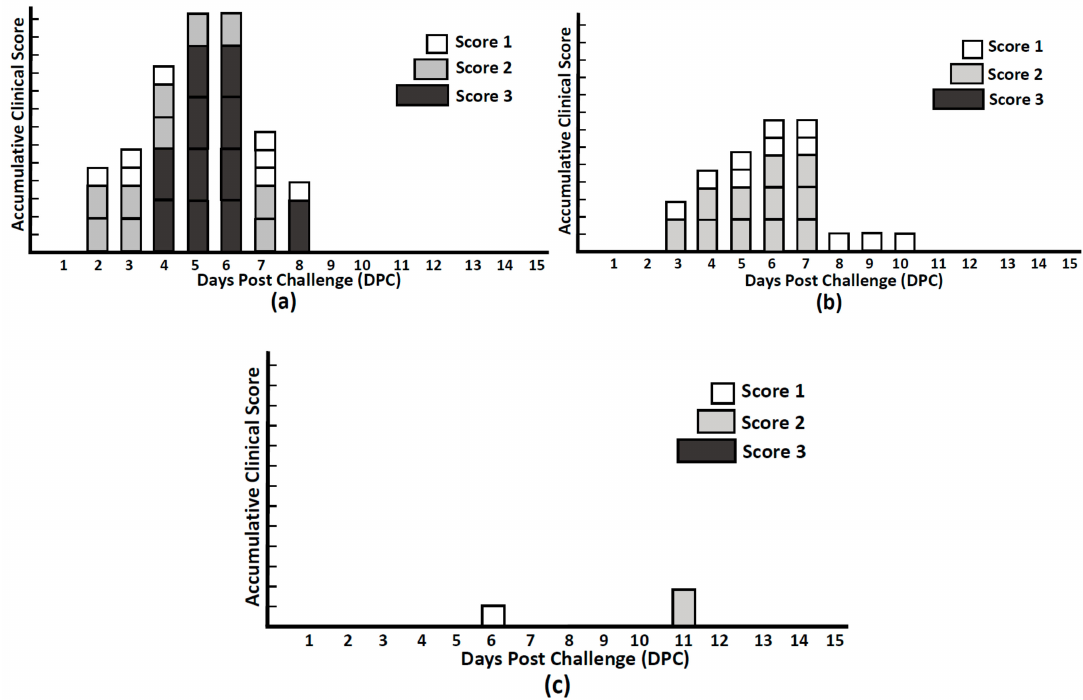
Figure 10. The accumulations of stool scores in the control group ( a ); S1-Bac group ( b ); and S-Bac ( c ) groups after the highly virulent porcine epidemic diarrhea virus (PEDV-PT) challenge. The clinical signs were scored by the following rules: 0, normal stool; 1, loose consistency of the stool; 2, semi-fluid consistency of the stool; 3, watery diarrhea. Each piglet was orally challenged with 5 × 10 5 TCID50 PEDV-PT-P6&7 at day post vaccination 28 (day post challenge 0). A total of 15 days’ observation period was taken after challenge. The blank square represents the score 1 (loose consistent stool); the light-gray square represents the score 2 (semi-fluid stool); the dark-gray square represents the score 3 (watery